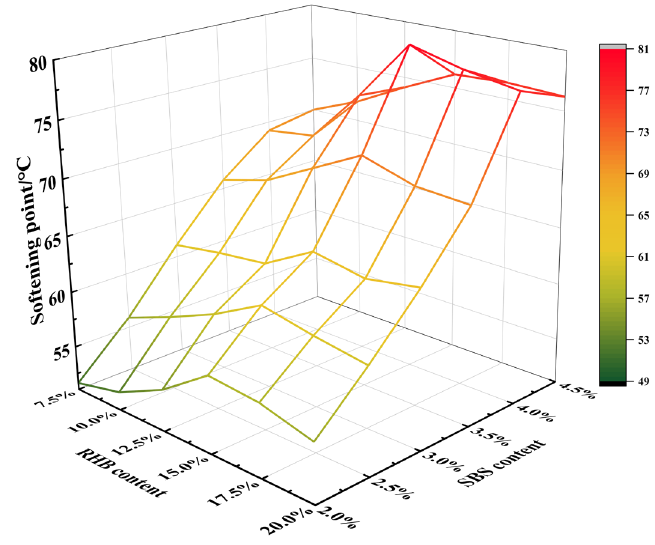
Figure 4. Softening point of composite-modified asphalt.